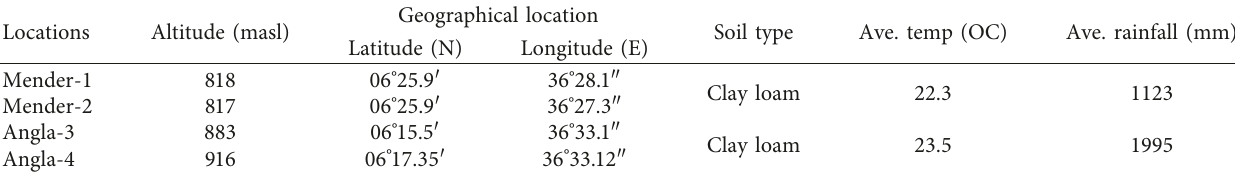
Table 1: Description of experimental